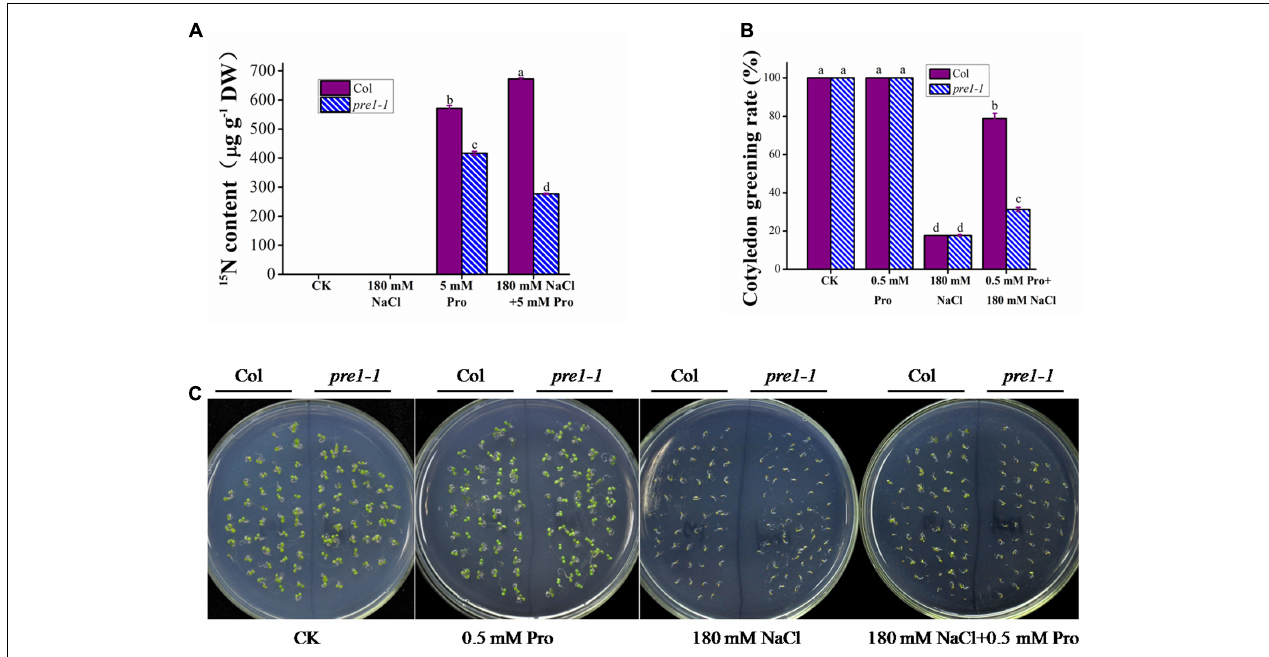
FIGURE 5 | The effect of salt stress treatment on exogenous proline uptake and beneficial effects of increased proline uptake on salt tolerance in Arabidopsis seedlings. (A) The proline uptake of wild-type and pre1-1 12-day-old seedlings following a 10 h treatment with 0.5 × MS liquid medium containing 5 mM L -proline (including 2.5 mM 15 N labeled L -proline) with or without 180 mM NaCl. (B,C) The seeds of wild type (Col) and the pre1-1 mutant were germinated on 0.5 × MS medium containing 180 mM NaCl with or without 0.5 mM L -proline (Pro), grown for 5 days. The survival rate (B) (the number of seedlings to compile statistics ≥ 200) of Col and pre1-1 seedlings and the phenotype (C) were measured and photographed, respectively. Col, wild-type Columbia. Experiments were repeated a minimum of three times with similar results. In (A,B) , the data are means ± standard error ( n = 3). Different letters above columns indicate significant difference ( P < 0.05, Duncan’s multiple range